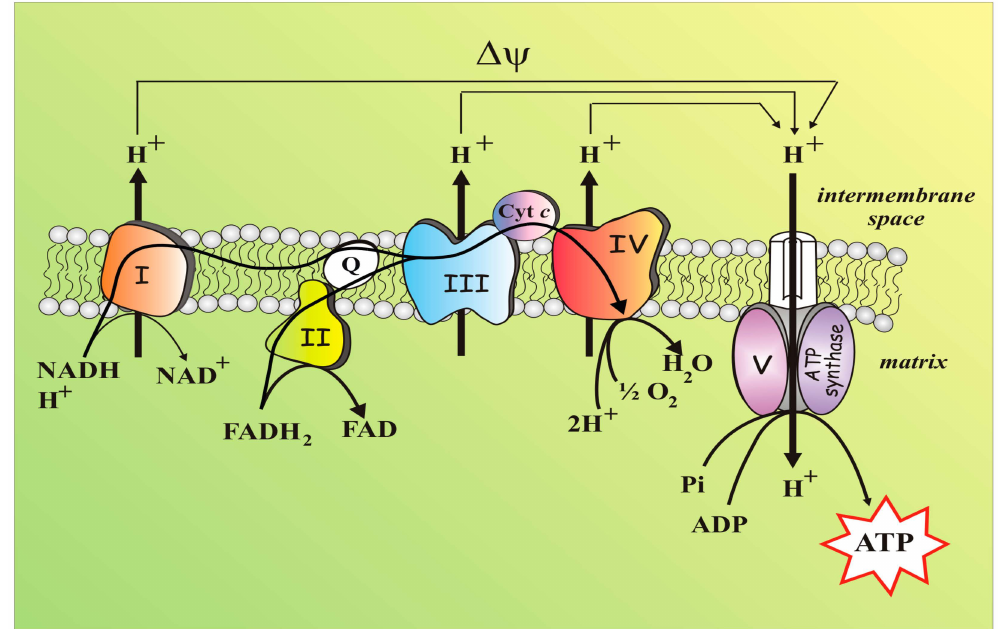
Figure 3. A schematic representation of the mitochondrial respiratory chain. Main abbreviations: ANT, adenine nucleotide translocator; I, Complex I or NADH-ubiquinone oxidoreductase; II, Complex II or succinate-ubiquinone oxidoreductase; III, Complex III or ubiquinone–cytochrome-c oxidoreductase; IV, Complex IV or cytochrome-c oxidase; V, Complex V or FoF1 ATP synthase; ∆Ψ , Mitochondrial membrane